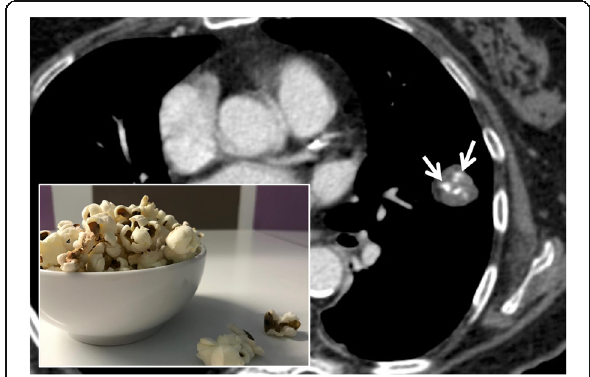
Fig. 24 Oreo cookie sign. On lateral chest radiograph the Oreo cookie sign is depicted: it consists of an increased radiopacity of the pericardium (black asterisk) — caused by pericardial effusion — which appears to be anteriorly and posteriorly delimited by two radiolucent lines (black arrows), caused by pericardial and epicardial fat. This radiographic pattern reproduces the so called “ Oreo cookie sign, ” similar to the famous biscuit